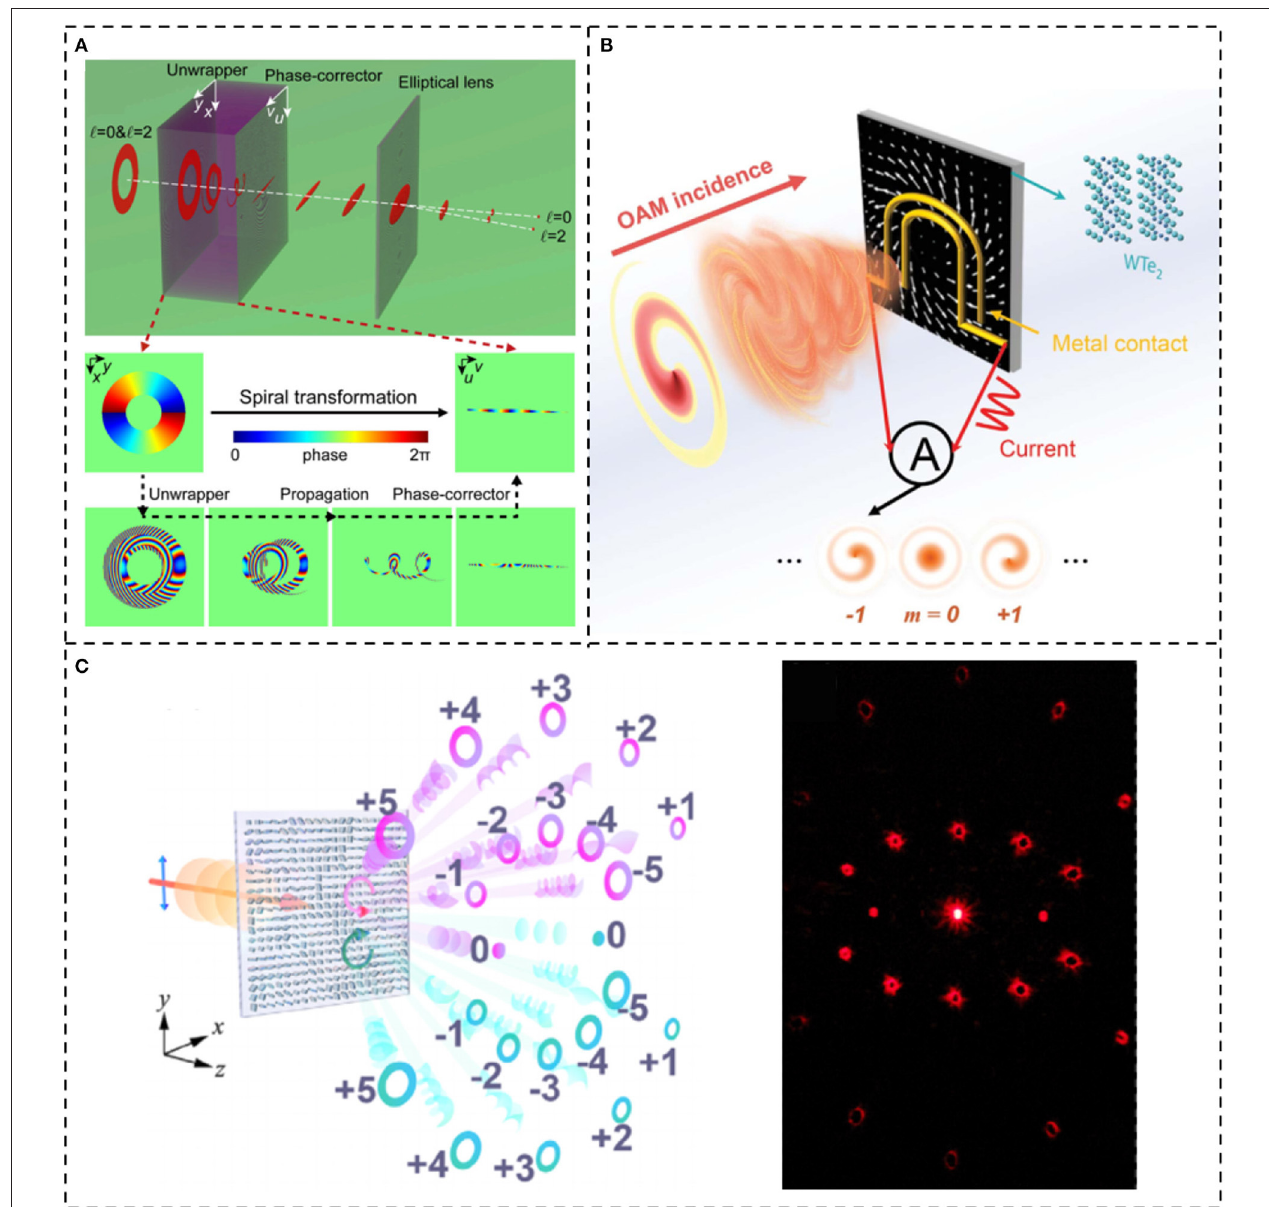
FIGURE 9 | Integrated devices for detection of spatial-structured light beams. (A) A spiral transformation device integrated on a dielectric slab for efficient sorting of optical vortex beams. Reprinted from Wen et al. [94]. (B) An integrated device converting different topological charges of optical vortex beams into different magnitudes of photocurrent. Reprinted from Ji et al. [98]. (C) Dielectric metasurface for multiple optical vortex beams detection. Reprinted from Zhang et al.